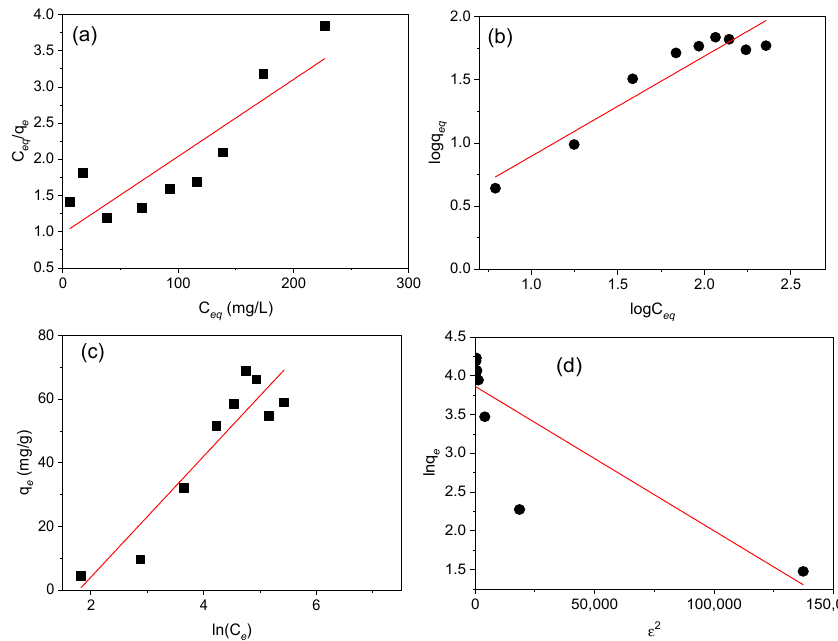
Figure 8. Langmuir, Freundlich, Temkin, and Dubinin–Radushkevich isotherm plots. ( a ) Langmuir isotherm showing the adsorption variation ( C e / q e ) against the equilibrium concentration (Ce), ( b ) Freundlich isotherm representing variation of log q e against log C e , ( c ) Temkin isotherm plot of q e (mg/g) against ln( C e ), and ( d ) Dubinin–Radushkevich isotherm representation of ln q e against ε 2 for adsorption of Cd(II) onto MAAC beads for 1